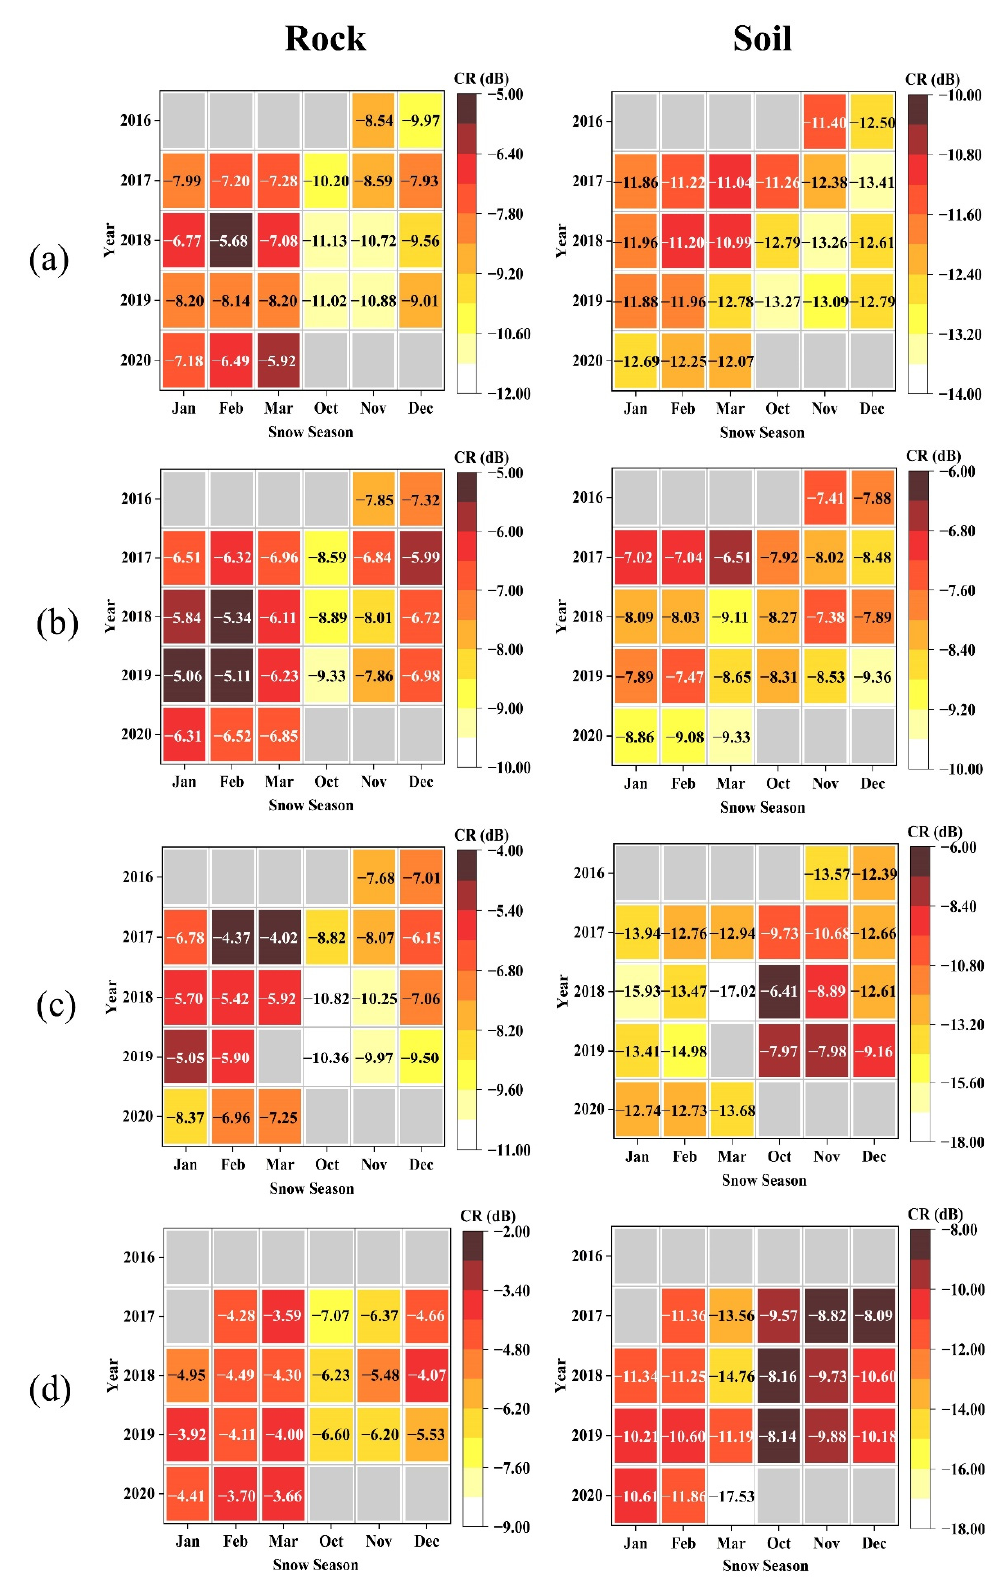
Figure 7. Monthly CR variations for four typical study areas during the snow season (October to March of the following year) between 2016 and 2020. Gray blocks represent no available data: ( a ) FV; ( b ) RS; ( c ) NK; ( d ) AP.